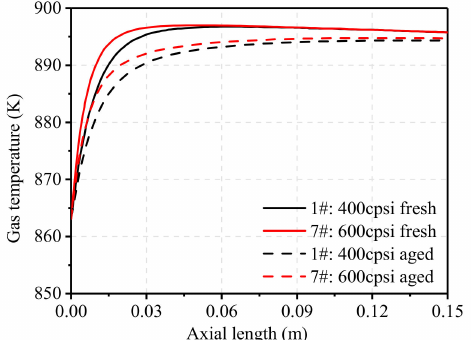
Figure 16. E ff ect of pore density on gas temperature